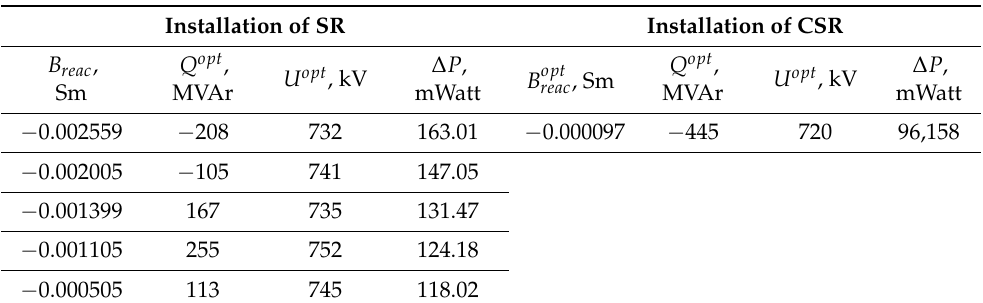
Table 10. Results of parametric optimization when using CSR and SR for bulk electrical power network with extra-high voltage power lines with optimal transposition